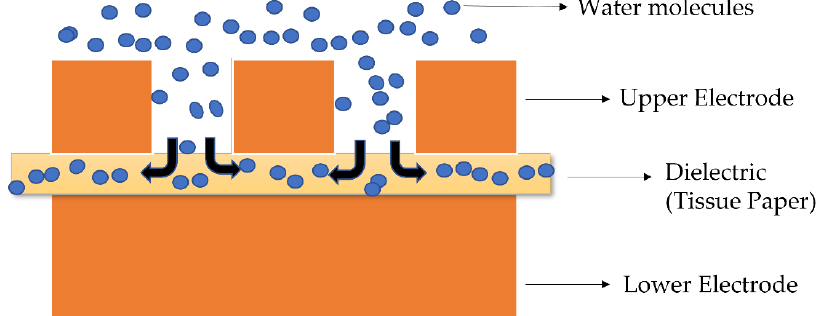
Figure 3. The working principle of a parallel-plate, capacitor-based sensor.